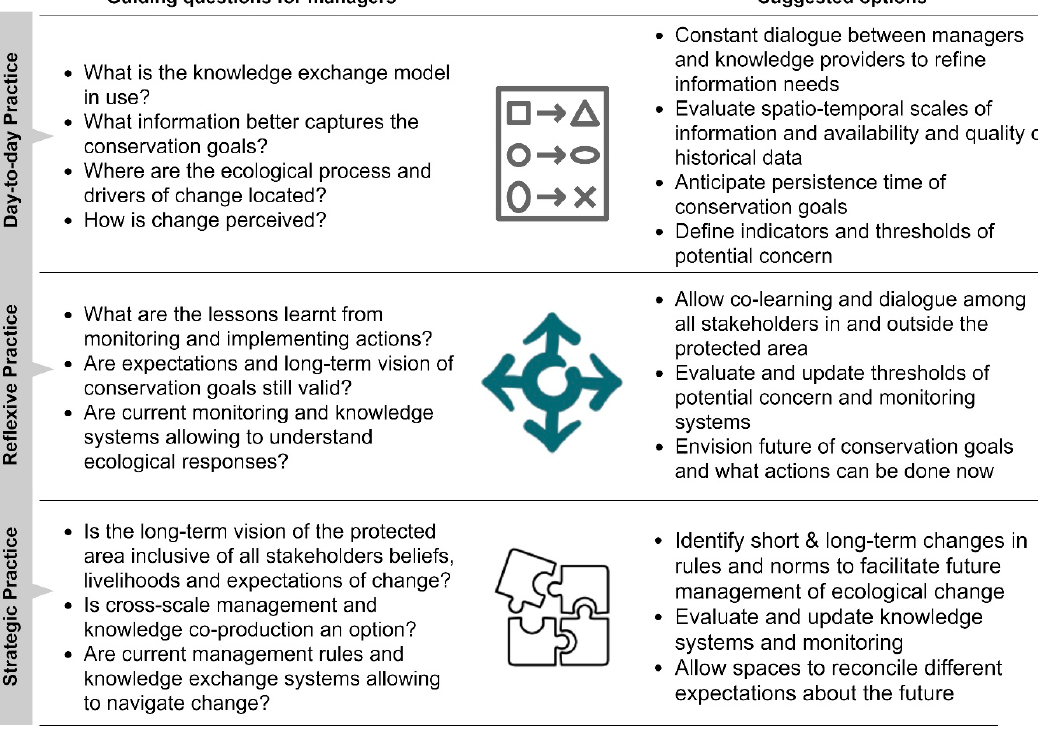
Figure 2. Illustrative example of the guiding questions and options for managers, to guide the discussion about multidimensional knowledge-based processes. Tables A1, A2, and A3 expand the questions at each level.